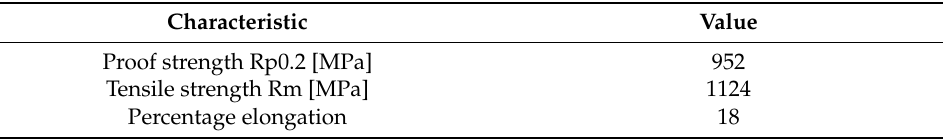
Table 2. Mechanical characteristics of steel after heat treatments